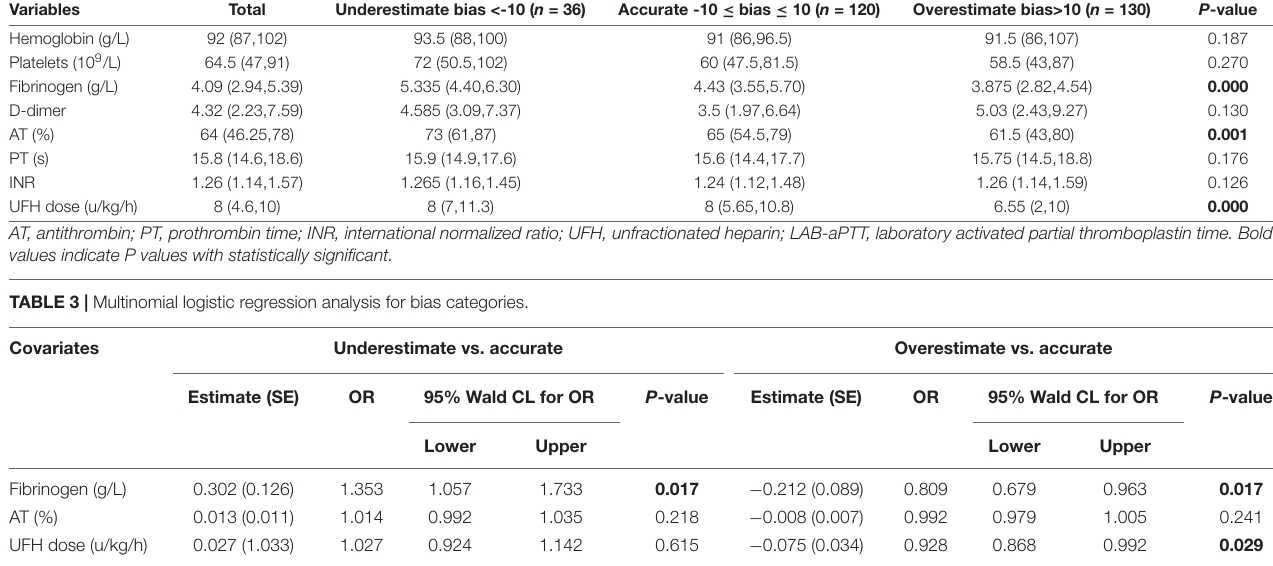
TABLE 2 | Univariate analysis for bias categories. Variables